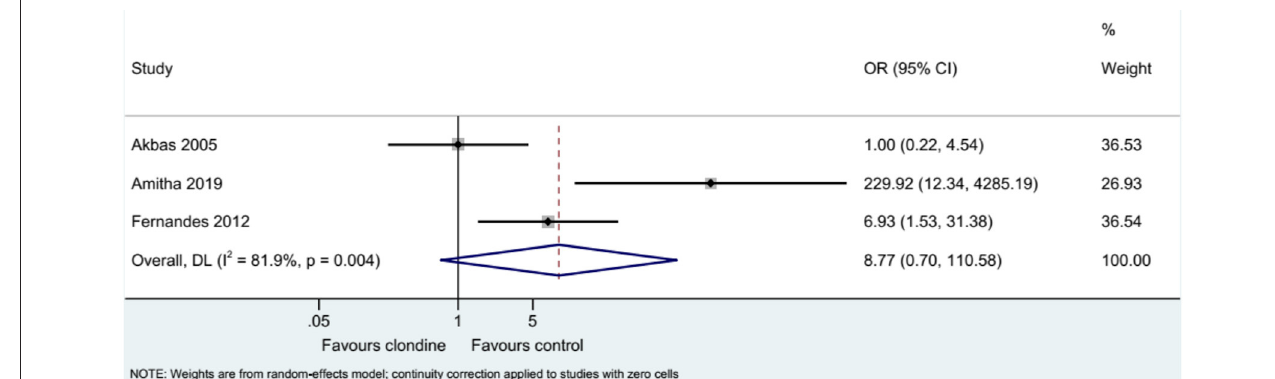
FIGURE 9 | Total numbers of analgesia of post-requirements.